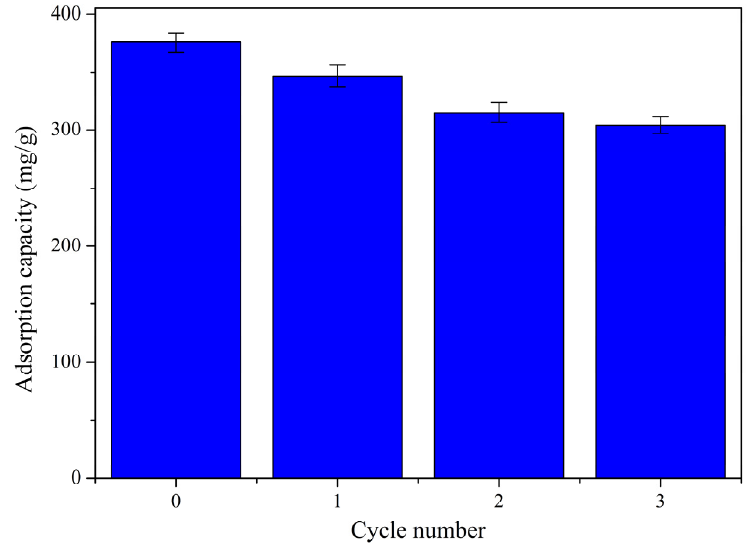
Figure 5. Reuse and regeneration of MTPG for phosphate uptake (C 0 = 1000 mg/L, MTPG = 0.4 g/L, pH = 5, t = 24 h).